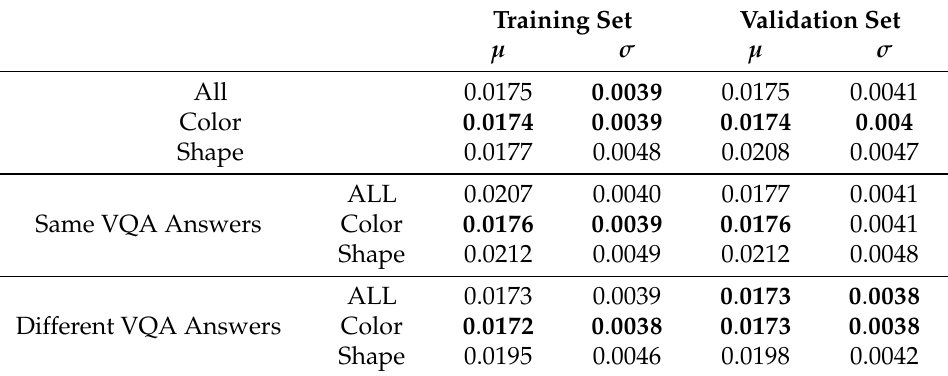
Table 2. Mean ( µ ) and standard deviation ( σ ) of the (cid:96) 1 -norm computed across the training and validation set and split across